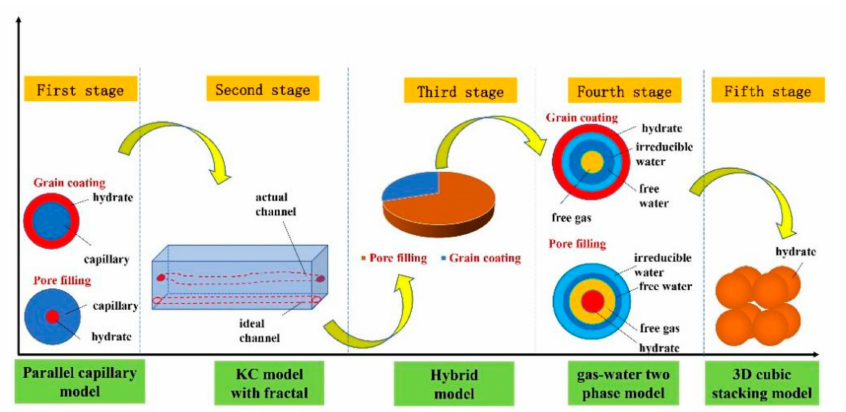
Figure 3. Evolution of normalized permeability models in